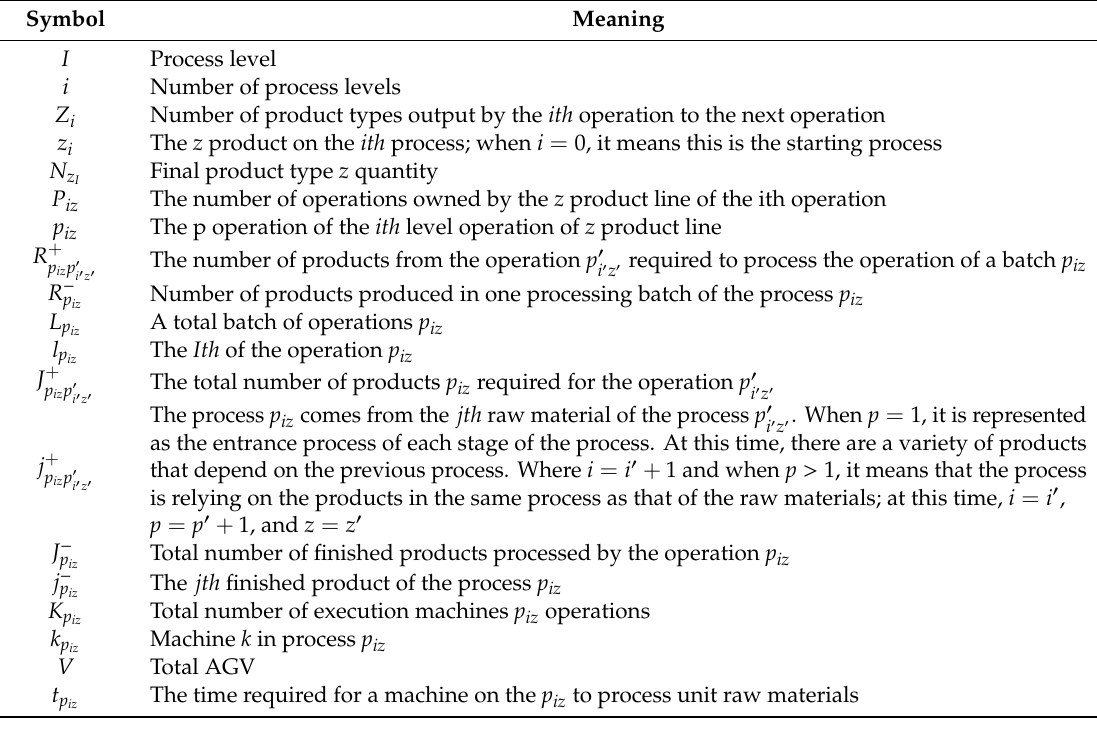
Table 1. Symbol definitions. AGV: automated guided vehicle.